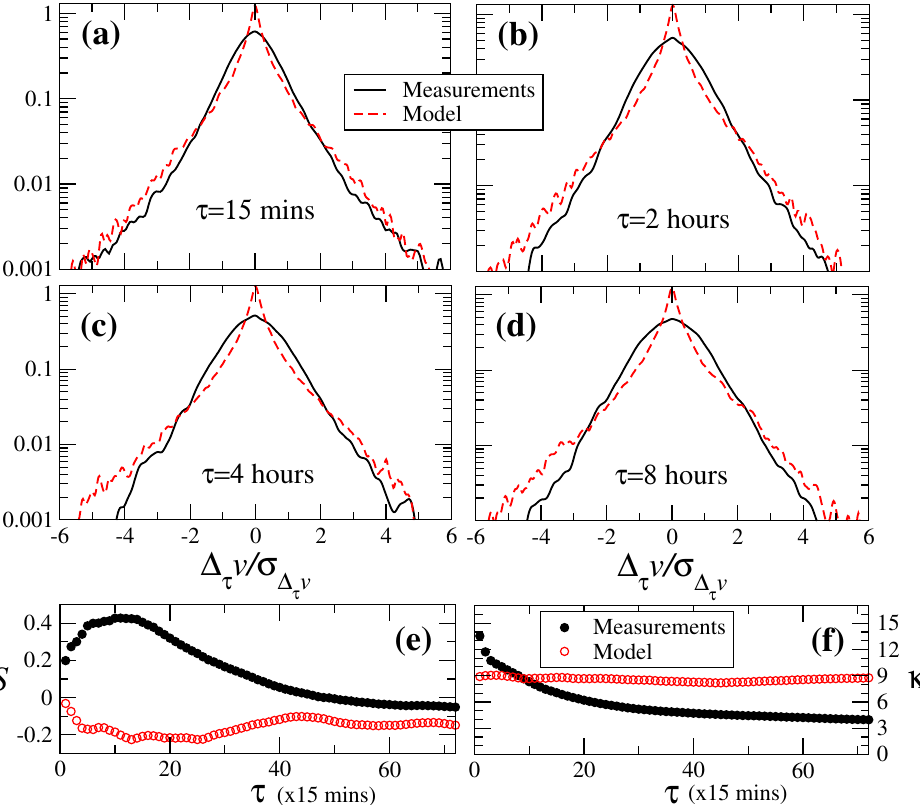
Figure 7. ( a – d ) Increment statistics of the original wind speed measurements, ∆ τ v , for different time-lags τ = 0.25, 2, 4, 8 and 16 h. The solid (black) lines indicate the measurements, while dashed (red) lines indicate the respective surrogate data set obtained with the nested ARIMA model for the set of wind speeds. ( e ) Skewness and ( f ) kurtosis of the wind speed increments as a function of the time-lag τ